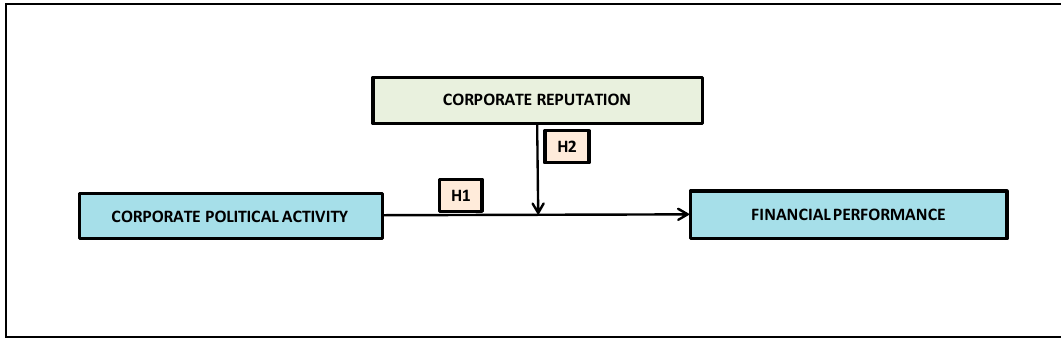
Figure 1. Theoretical Framework.